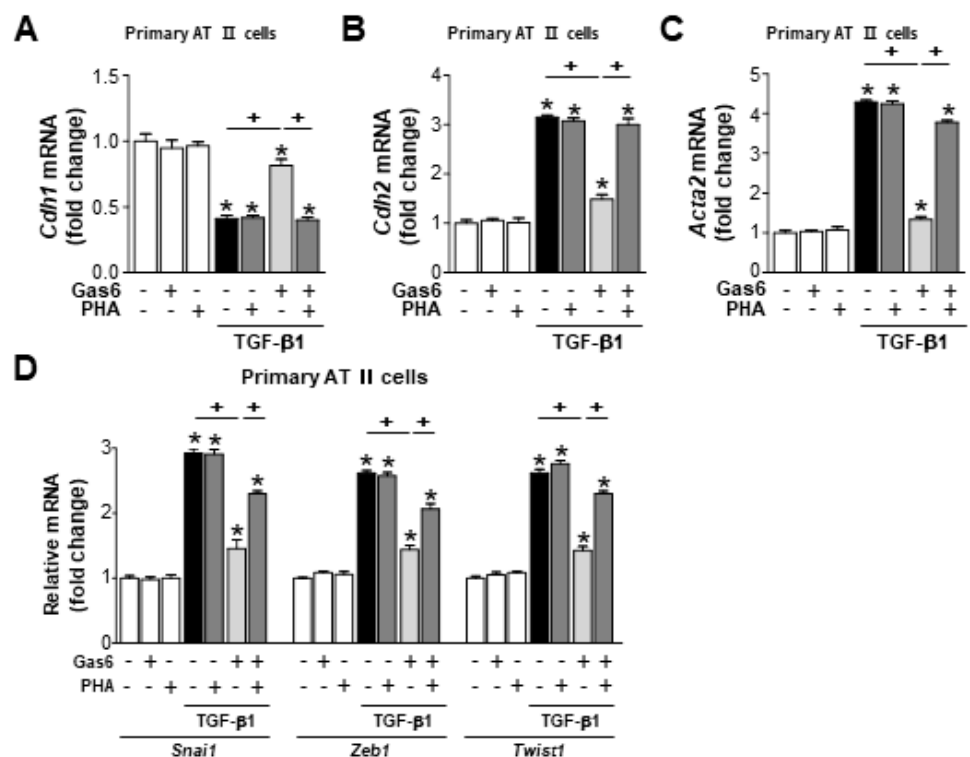
Figure 6. Rho kinase is involved in the Gas6-induced inhibition of EMT markers and EMT transcription factors in primary alveolar type II cells. Primary alveolar type II (AT II) cells were treated with 30 µ M Y-27632 for 1 h prior to treatment with 400 ng / mL Gas6 for 20 h and then stimulated with 10 ng / mL TGF- β 1 for 48 h. ( A – D ) qPCR analysis of the mRNA levels of EMT markers and EMT transcription factors. Values represent the mean ± SEM of three independent experiments. * p < 0.05 compared with control; + p < 0.05, as indicated.